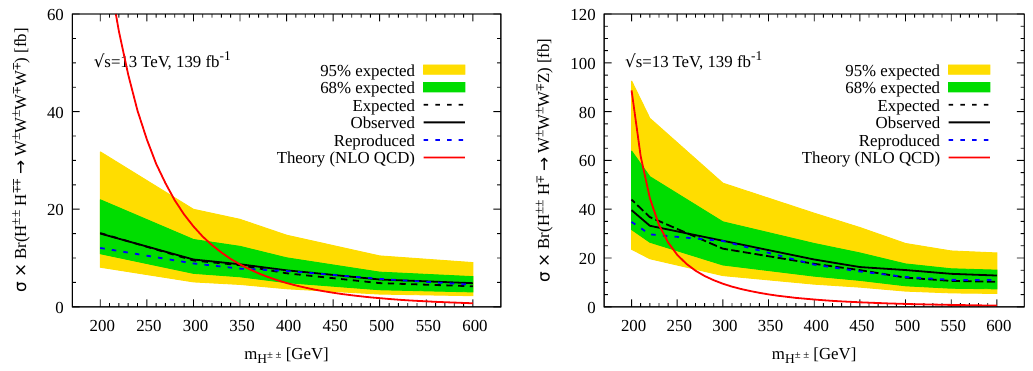
Figure 2 . Left (right): the ATLAS observed and expected 95% CL upper limits on the H ±± H ±± ( H ±± H ∓ ) production cross-section times branching fraction. The reproduced 95% CL upper limit is represented by the blue dashed